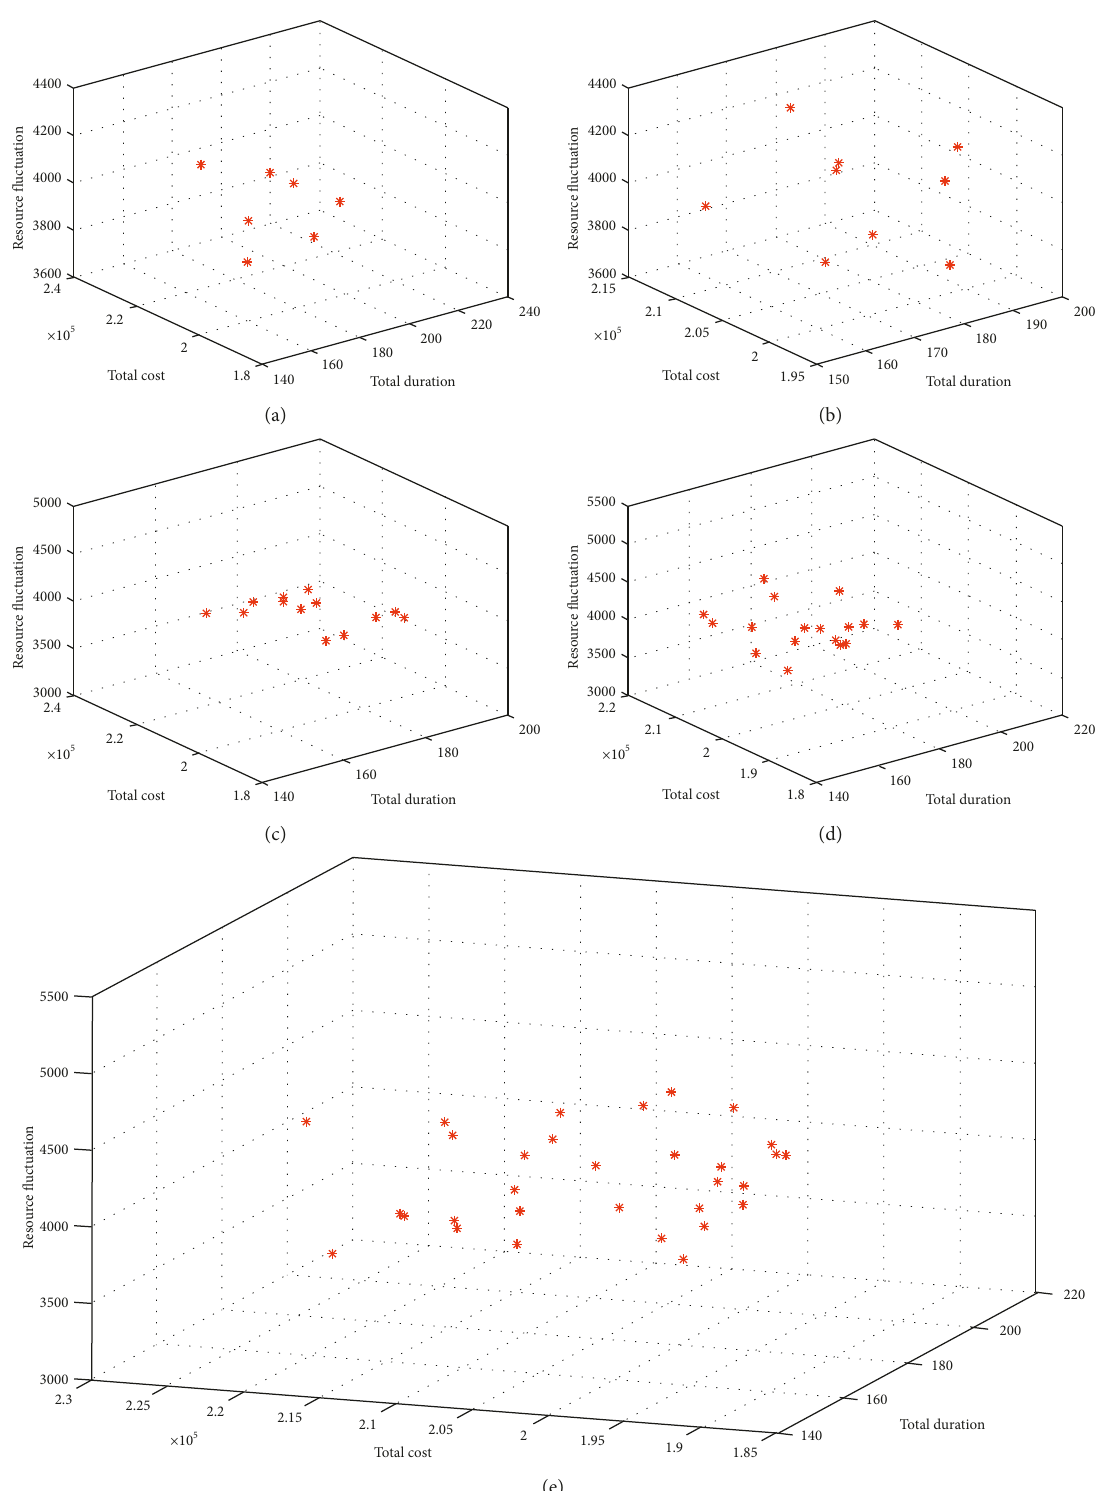
Figure 8: Optimal solutions generated by SFLA. (a) Nondominated solutions after 5th generation. (b) Nondominated solutions after 10th generation. (c) Nondominated solutions after 20th generation. (d) Nondominated solutions after 50th generation. (e) Pareto front solutions of the TCRTO model after 100th